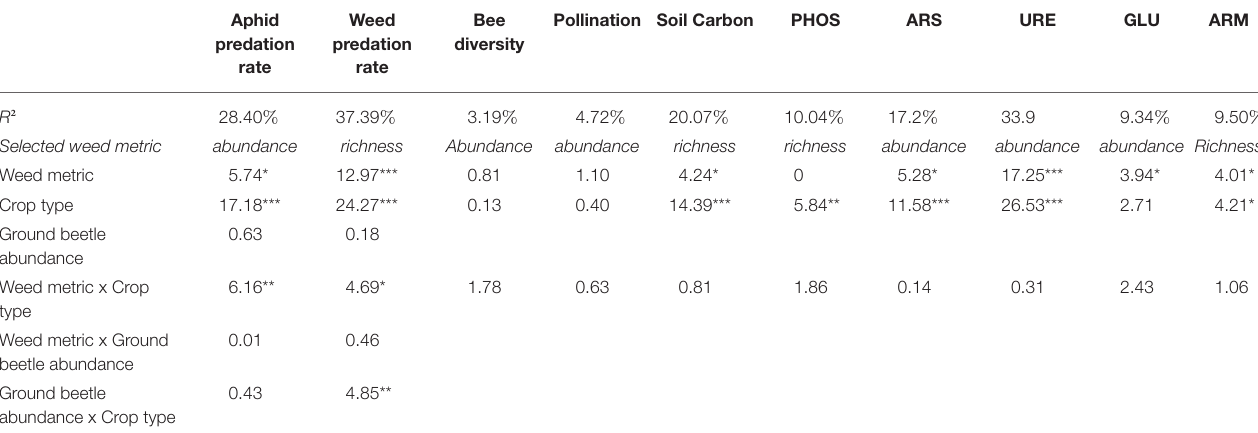
TABLE 2 | F-Statistics for the effects of weeds (abundance or richness) and crop type on each individual